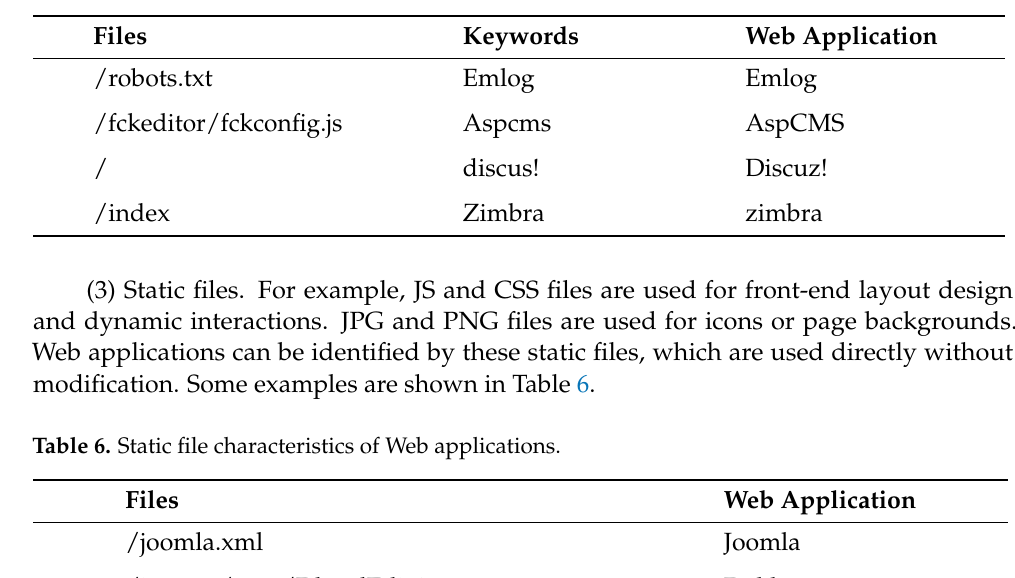
Table 5. Signatures of text belonging to Web applications.